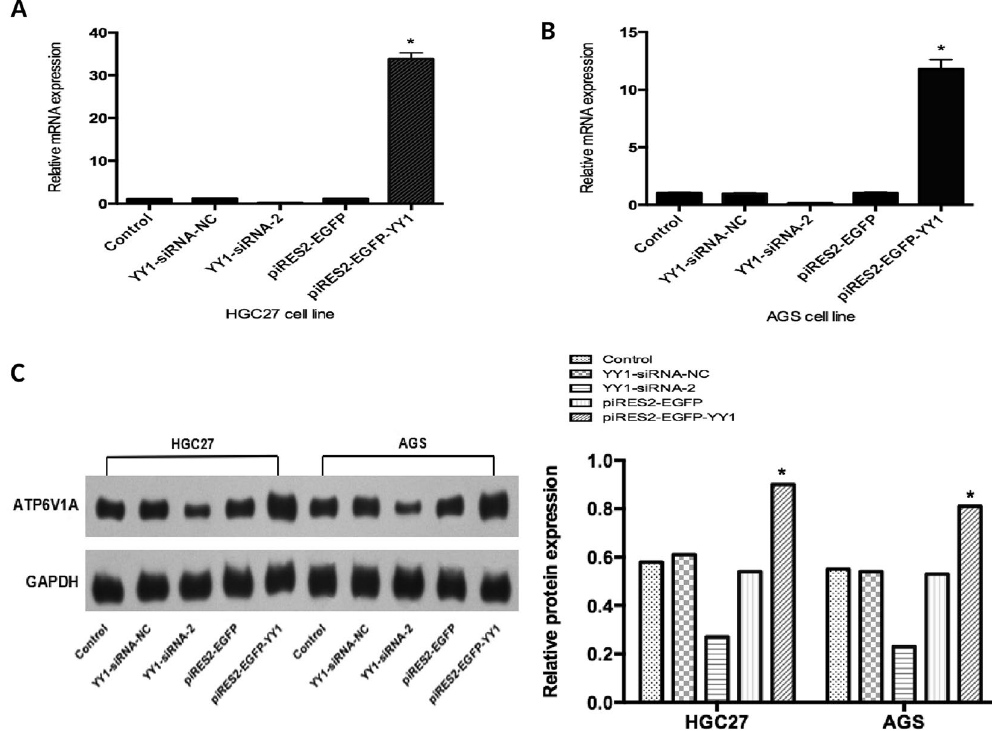
Figure 4. YY1 transcriptionally regulates ATP6V1A in GC cells. ( A ) RT-PCR for the effects of YY1 expression on ATP6V1A mRNA levels in GC cell lines. Following the transfection of YY1 siRNA into the HGC-27 gastric cancer cells, ATP6V1A mRNA levels were significantly decreased. In contrast, the mRNA expression levels of ATP6V1A were dramatically increased with the overexpression plasmid piRES2-EGFP-YY1. ( B ) Similar results were also detected in the AGS gastric cancer cells. ( C ) Western blot for the effects of YY1 expression on ATP6V1A protein levels in GC cell lines. Left panel: Western blot showing that ATP6V1A protein levels were significantly decreased after transfection of YY1 siRNA into the HGC-27 and AGS gastric cancer cells, whereas the protein expression levels of ATP6V1A were significantly increased when these cells were transfected with the overexpression plasmid piRES2-EGFP-YY1. Note that GAPDH was used as a loading control. Right panel: Quantitative analysis of the band intensity from ( A ). * p < 0.05.